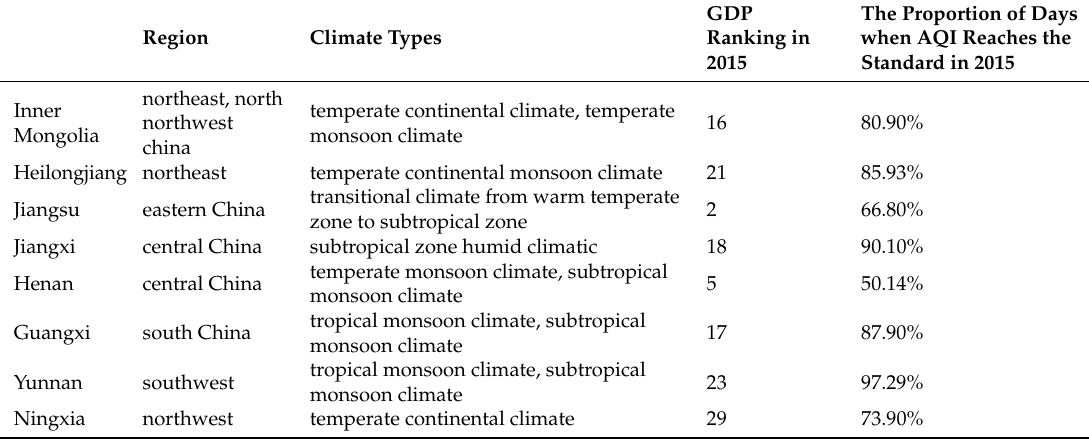
Table 2. The basic situation of the inspected